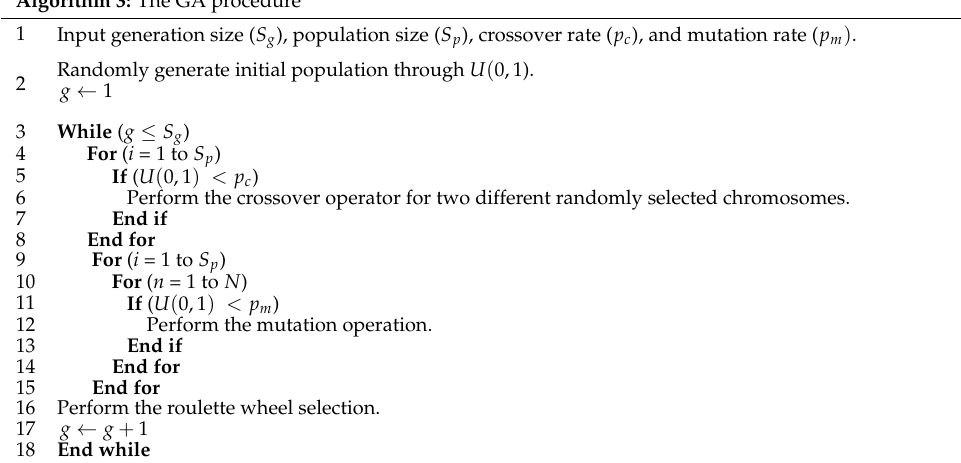
Algorithm 3: The GA